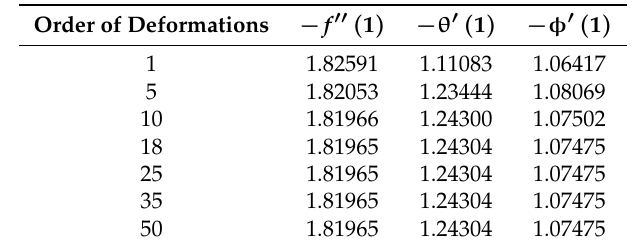
Table 2. HAM solution convergence at the upper disk when S = 0.2, M = Nt = 0.2, Nb = 0.5 and Sq = Le = Pr =